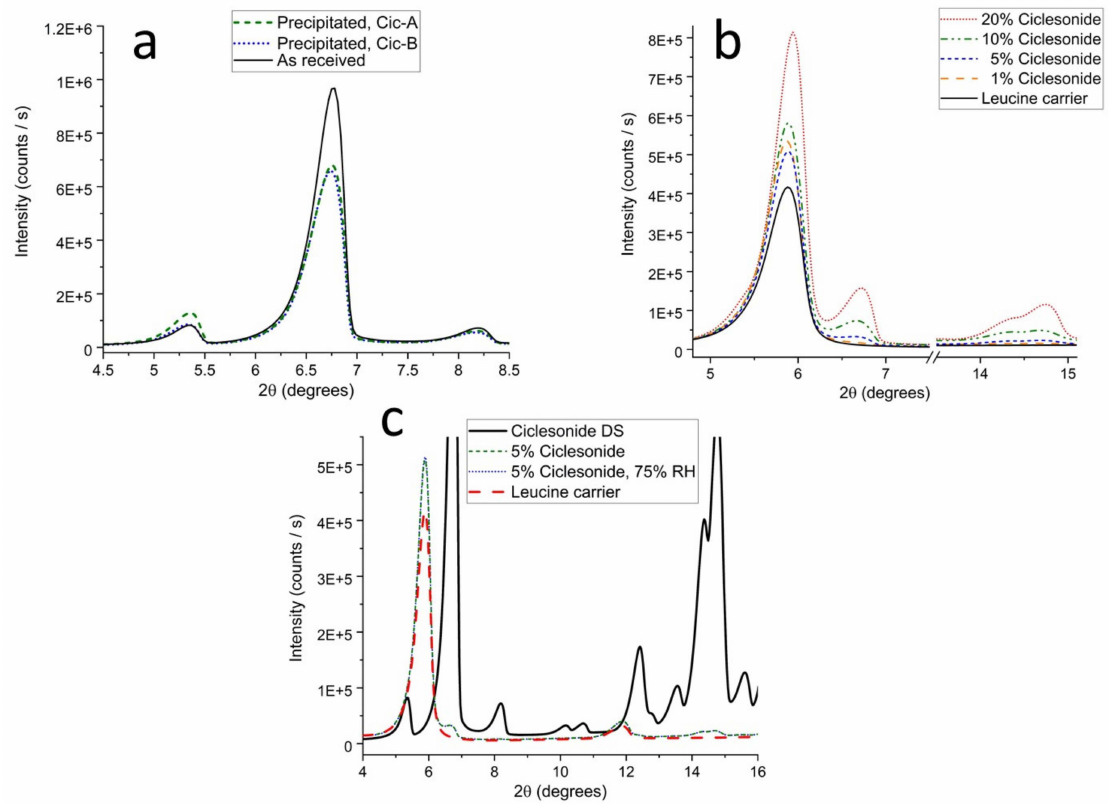
Figure 4. X-ray powder diffraction patterns for ciclesonide and leucine. ( a ) comparison of the diffraction patterns for the as received drug substance with two batches of particles prepared by flash nanoprecipitation (Cic-A, Cic-B); ( b ) comparison of the diffraction patterns at 1, 5, 10, and 20% w / w ciclesonide with the leucine carrier; ( c ) comparison of the diffraction patterns observed for a 5% w / w CPI drug product before and after exposure to 75% RH, with the patterns observed for the drug substance and leucine